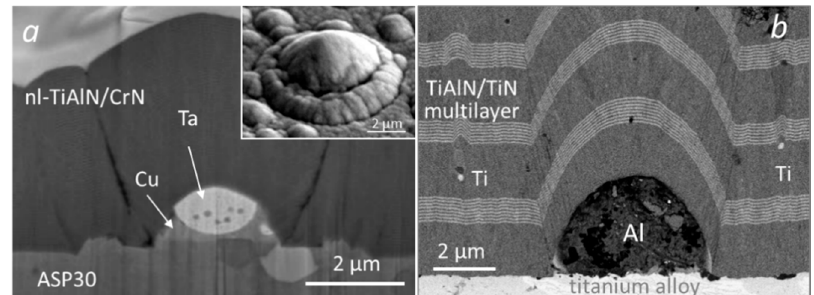
Figure 25. FIB image of a droplet-related defect in sputter-deposited nl-TiAlN / CrN hard coating. The seed composed of cooper and tantalum was formed during intensive (booster) ion etching ( a ). Two small Ti buried droplets and one large Al-based hemisphere with a flattened bottom formed during preparation of TilN / TiN multilayer using the cathode arc deposition technique ( b ). The multilayer TiAlN / TiN hard coating on the titanium alloy substrate was prepared at the company KCS Europe from